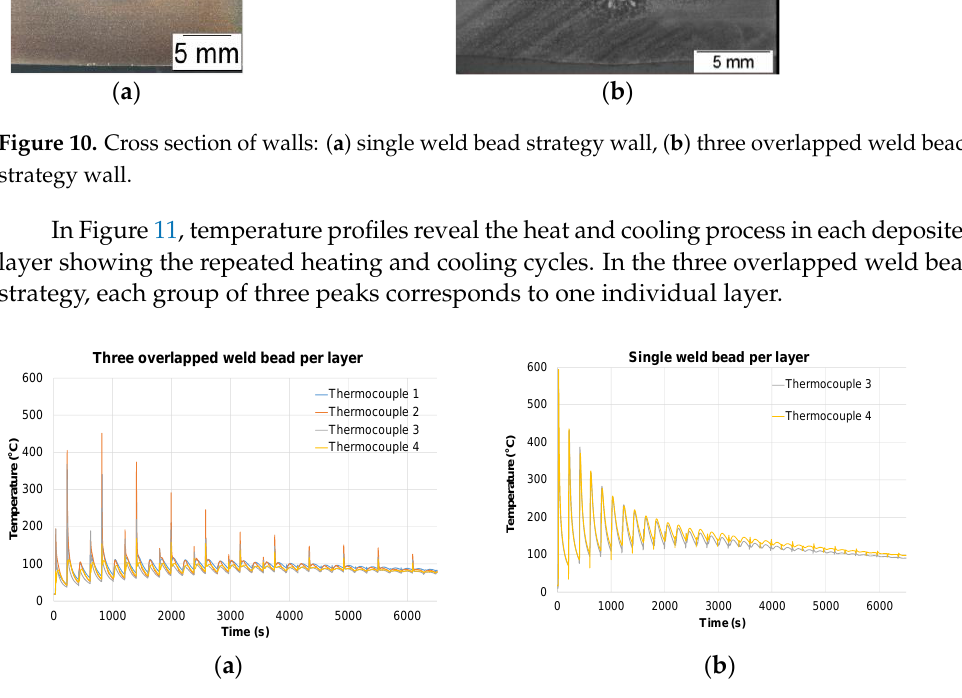
Figure 11. Temperature records for ( a ) three overlapped weld beads strategy wall and ( b ) single weld bead strategy wall.